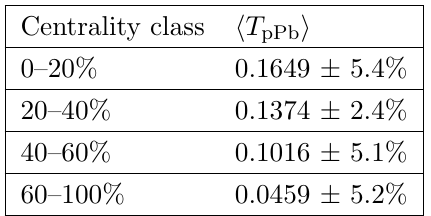
p s NN = 5 : 02 TeV obtained with the hybrid method